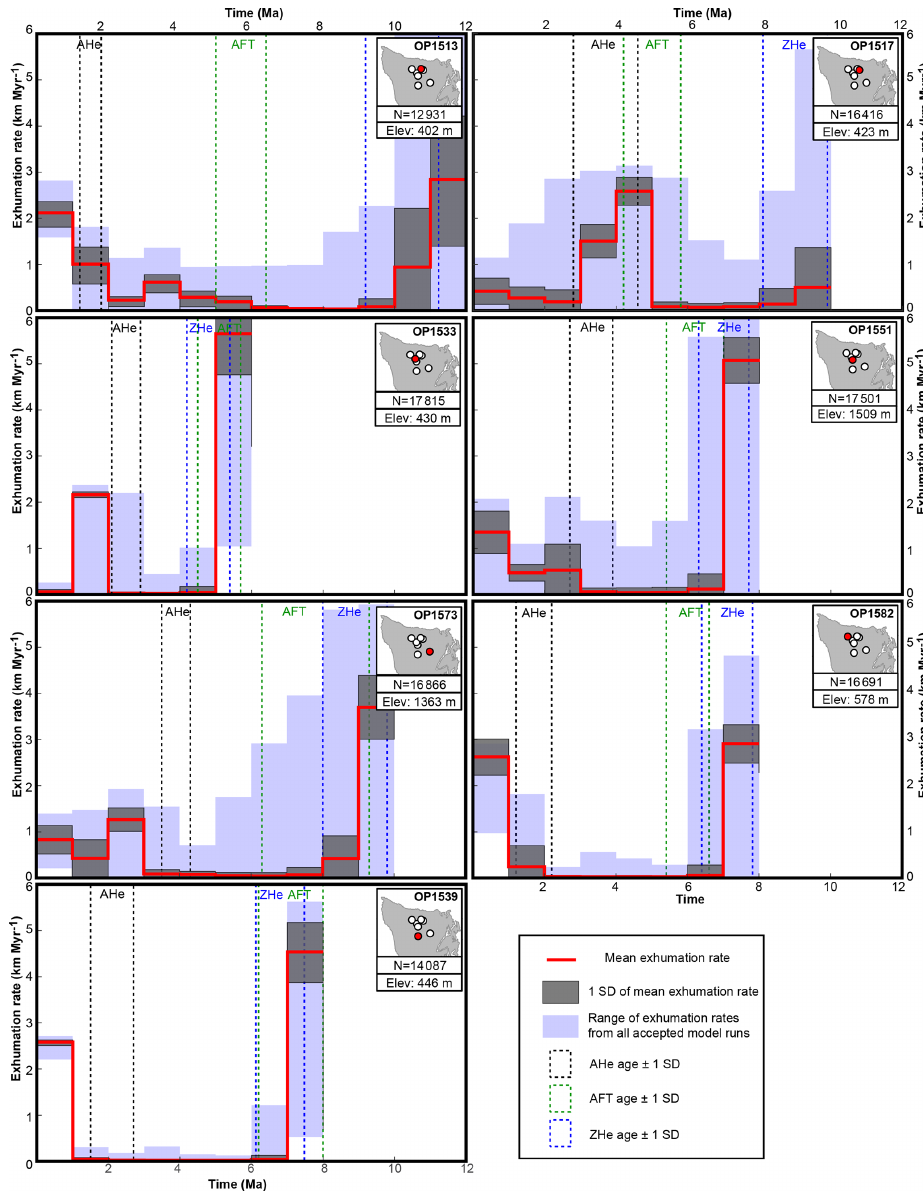
Figure 5. Results from thermo-kinematic Monte Carlo modeling for the seven considered samples (OP1513, OP1517, OP1533, OP1539, OP1551, OP1573, OP1582). The location of each sample within the Olympic Peninsula is shown, together with the respective elevation (Elev). The entire range of exhumation rates from the number of accepted model runs ( N ) is outlined by the blue shaded area, from which the mean rate and 1 standard deviation (1 SD) is calculated at each time step. Black, green, and blue stippled boxes outline measured AHe, AFT, and ZHe ages of the samples with 1